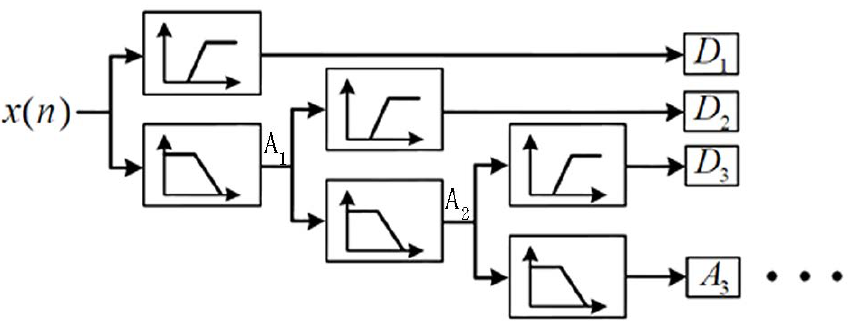
Figure 5. Diagram of the multiscale wavelet transform decomposition